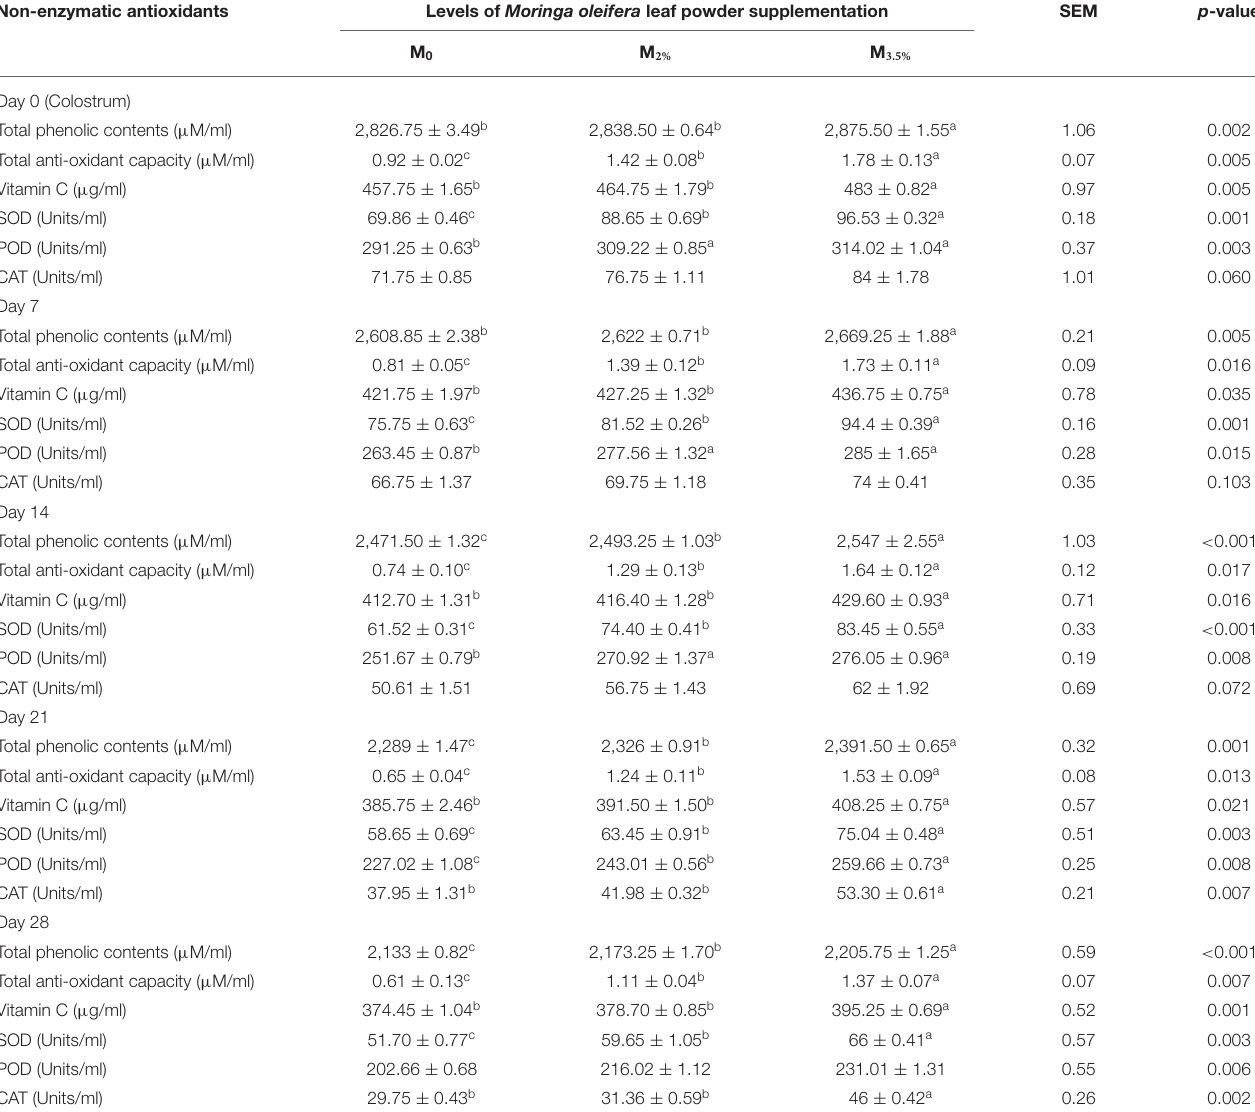
TABLE 9 | Effect of Moringa oleifera leaf powder supplementation on milk antioxidant parameters. Non-enzymatic